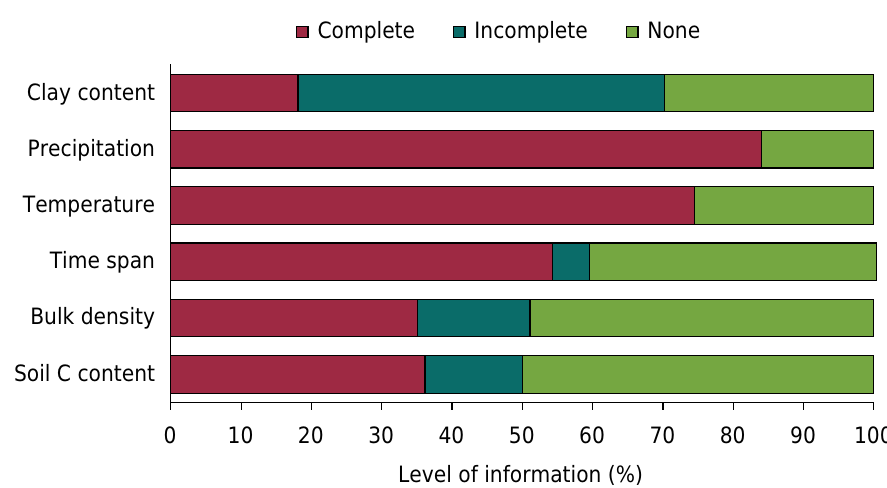
Figure 4. The lack of basic information in soil C studies across Brazilian Cerrado. Complete: available data for every evaluated plot and/or soil layer.